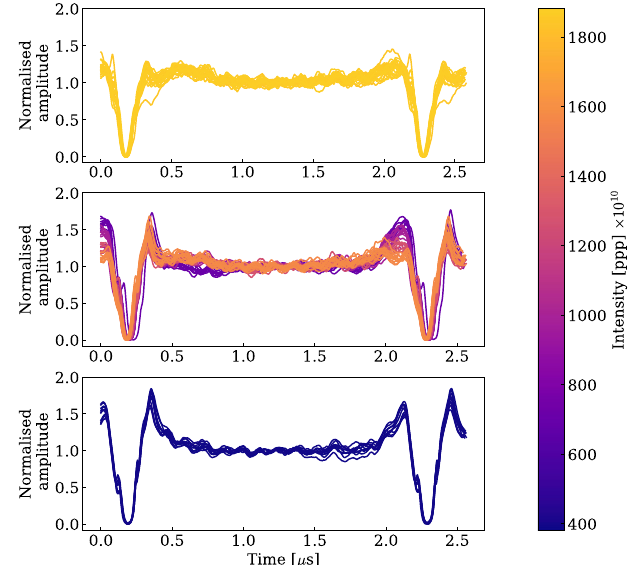
FIG. 10. Comparison of the low-pass filtered, normalized longitudinal line-density profiles at extraction at the same time in the rebucketing process for different acquisitions. The effect of the beam intensity on the line density and especially on the shoulders at the barrier edges can be seen for the same 180 ns gap size setting.